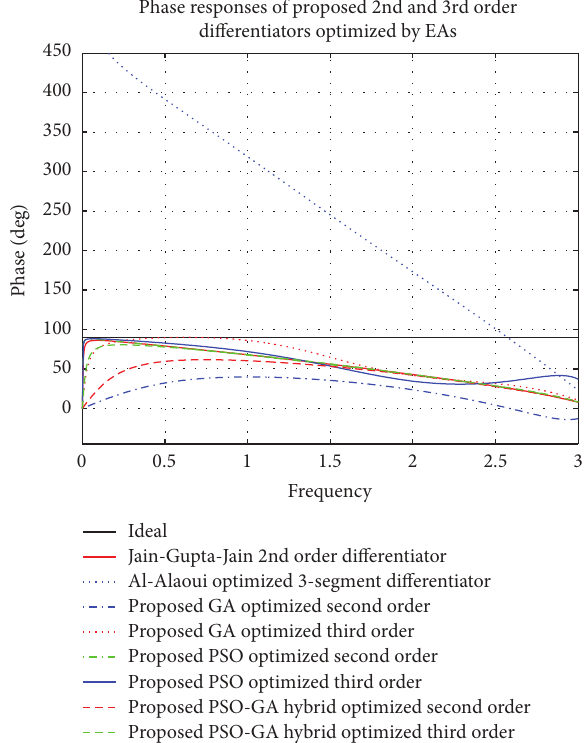
Figure 5: Comparison of phase responses of proposed optimized 2nd and 3rd order GA, PSO, and PSO-GA hybrid optimized digital differentiators with ideal and existing 2nd [32] and 3rd [1] order differentiators.